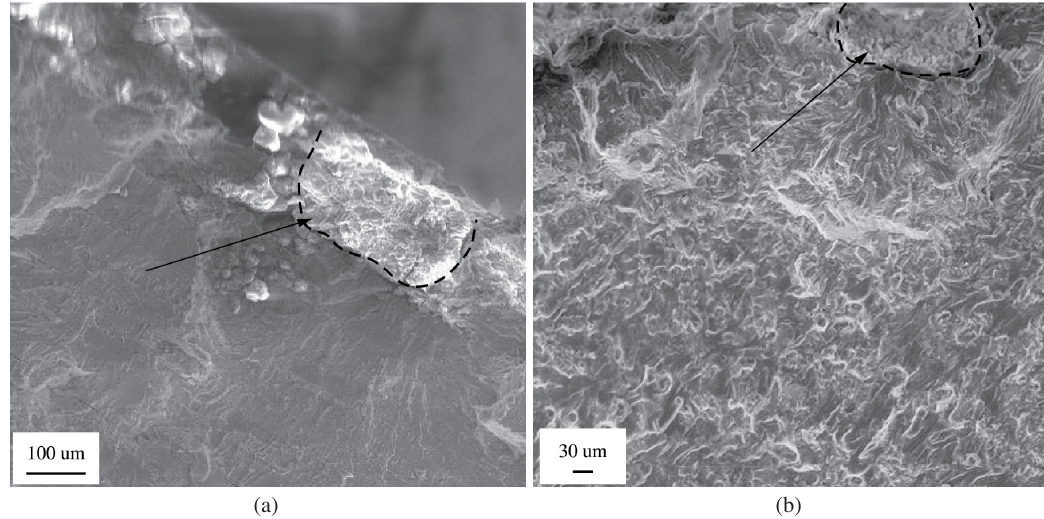
Figure 4. Fatigue crack nucleation sites from corrosion pits at the specimen surface (region marked with black arrows) (a) AA2524-T3 and (b) AA2198-T851, observed after conditioning and fatigue